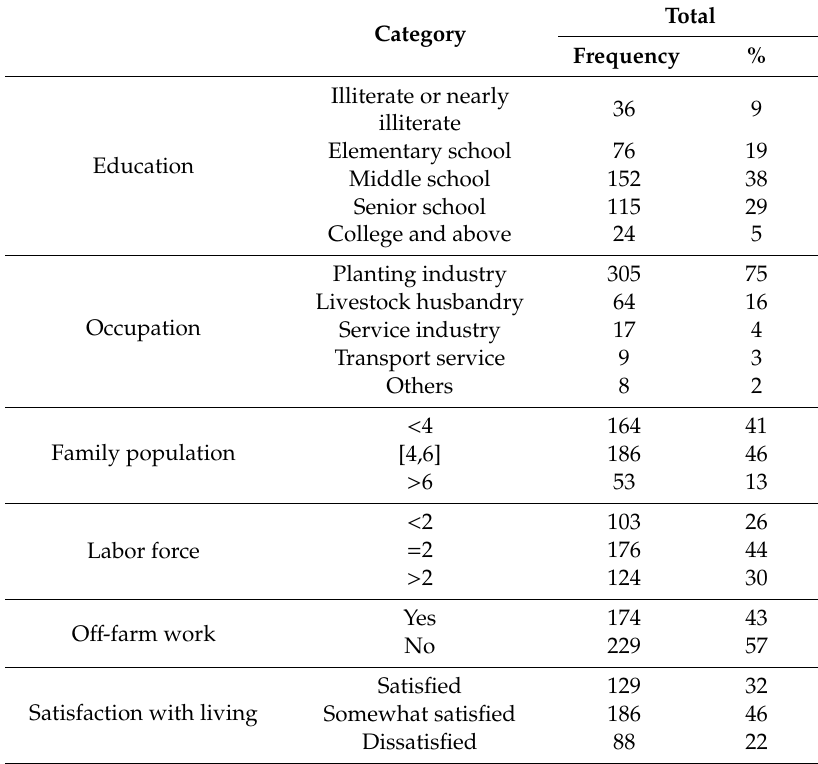
Table 1. Farmer demographics in the Manas River